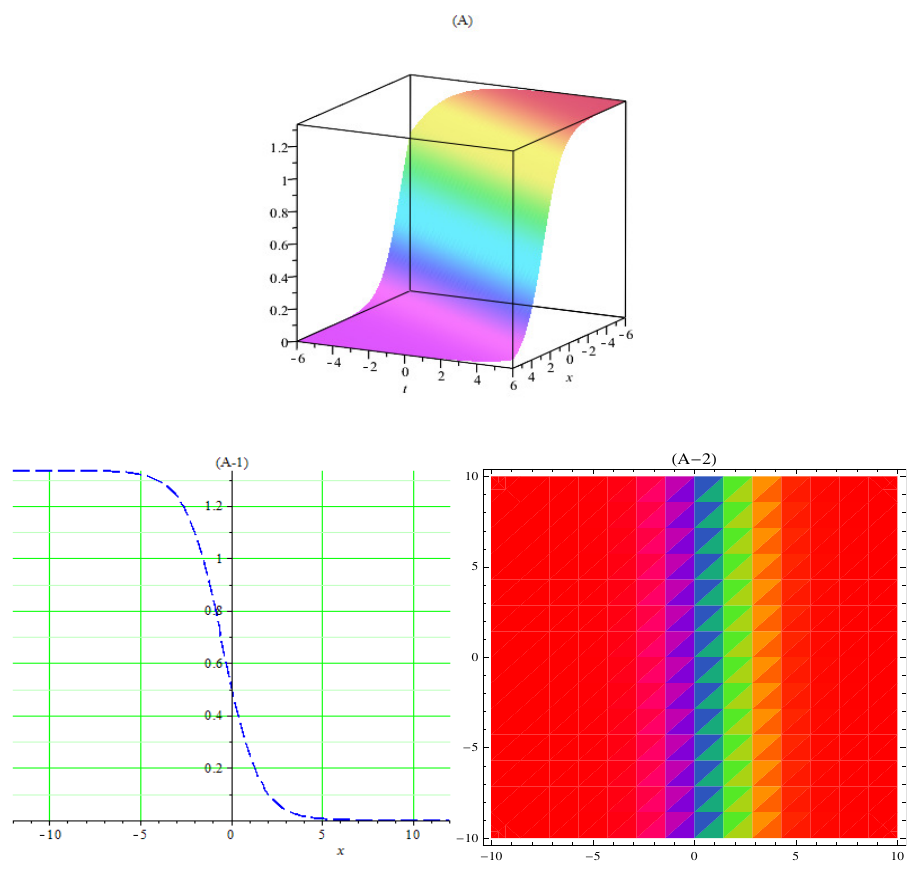
Figure 1. ( A ) 3D graph of kink soliton of (21) using l = 0.8, m = 0.3, µ = 0.2, d = 2.6, ζ = 0.65, V = 1.5. ( A-1 ) 2D plot and ( A-2 ) contour plot of